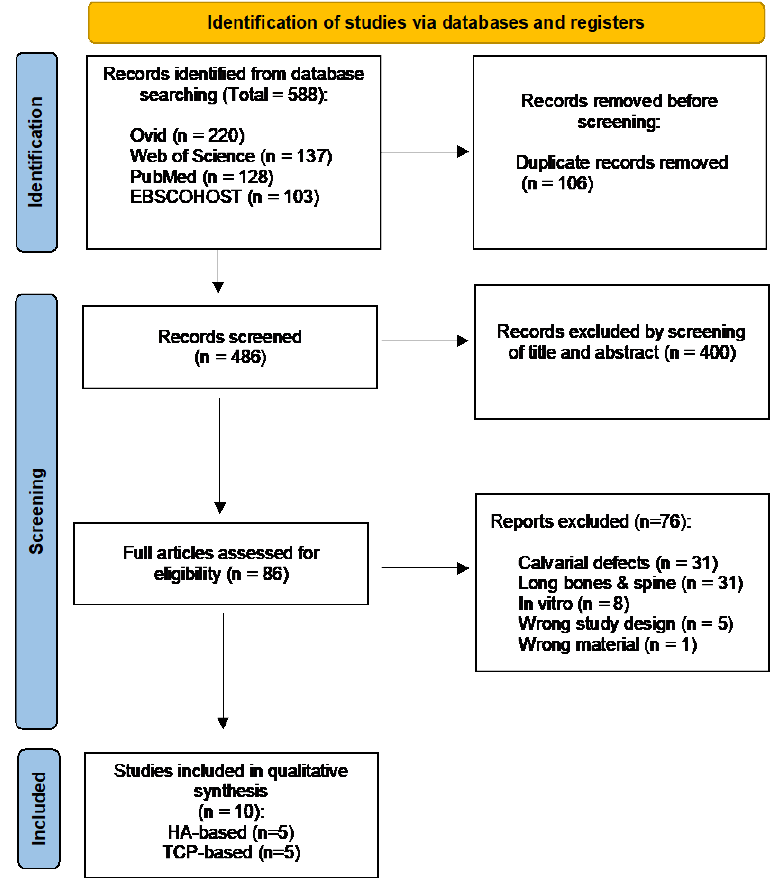
Figure 1. PRISMA flow diagram depicting the results of the search strategy.